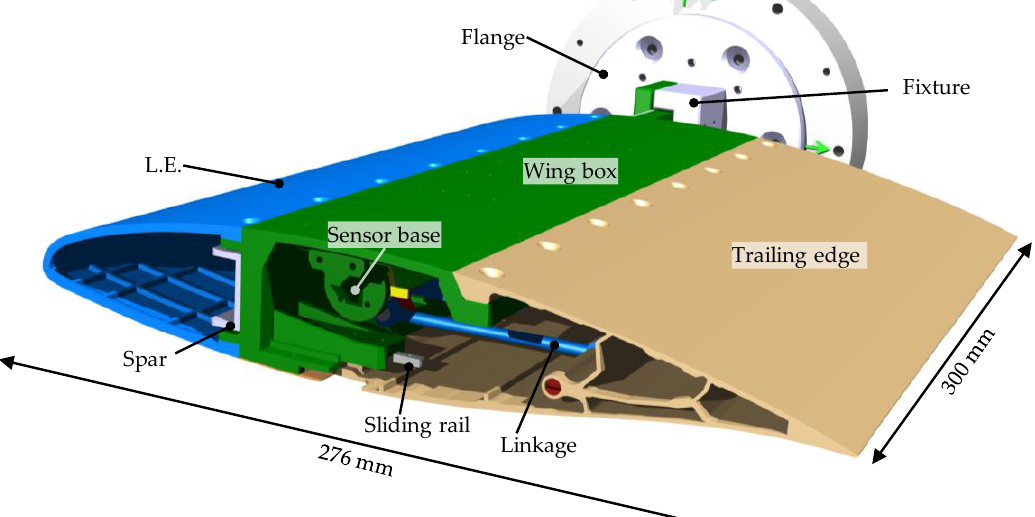
Figure 6. Isometric drawing of mTE4.